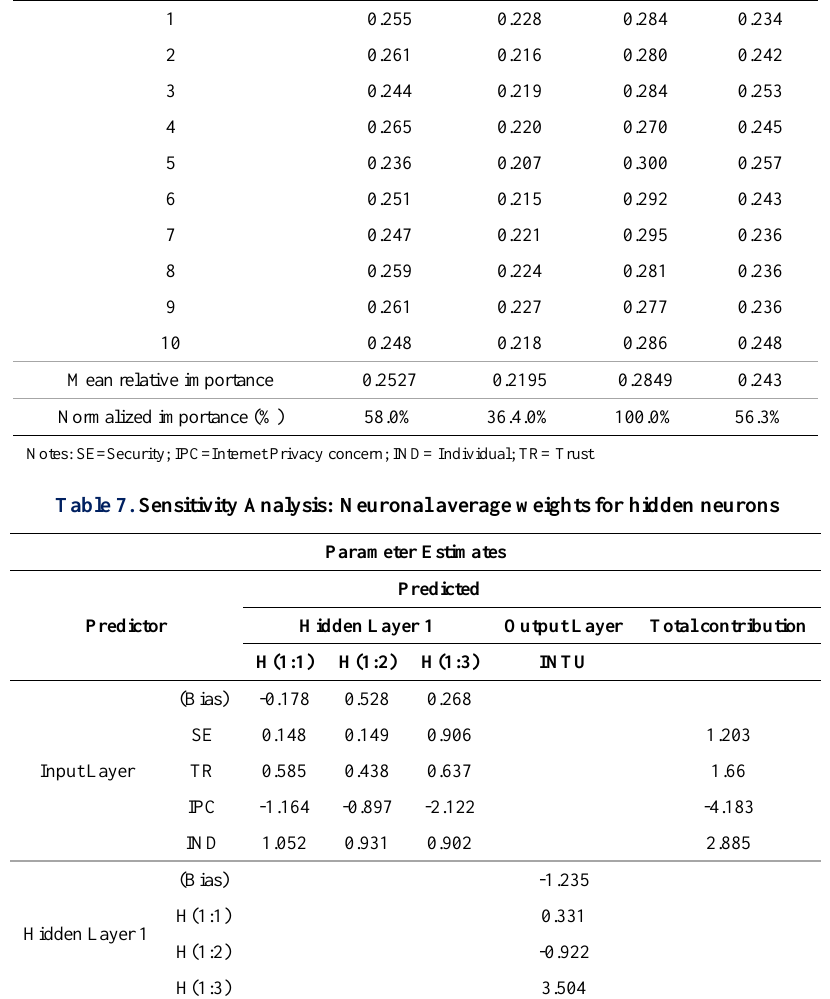
Table 6. Training and testing performance in terms of RMSE for a ten-fold ANN Neural Network